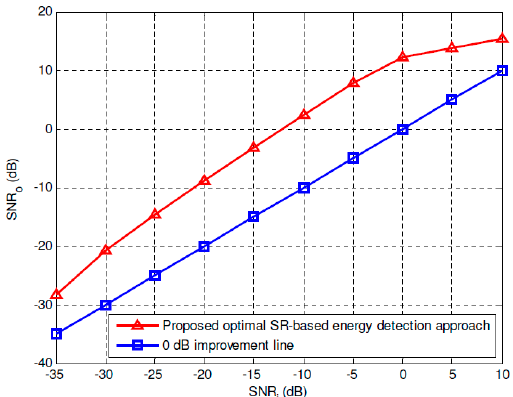
Figure 6. SNR o vs. SNR i by using the proposed optimal SR-based detection approach.